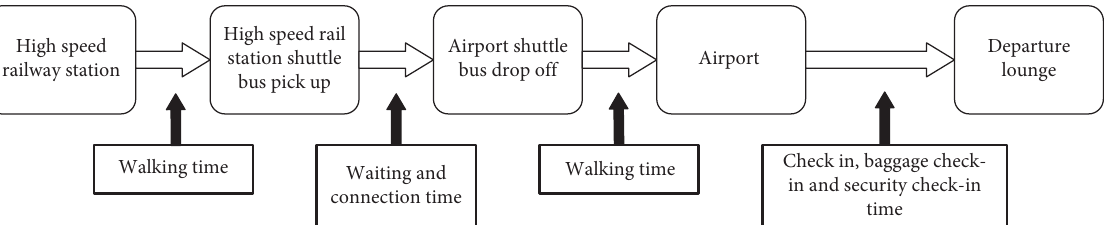
Figure 1: Waiting time of air-rail integration transfer.